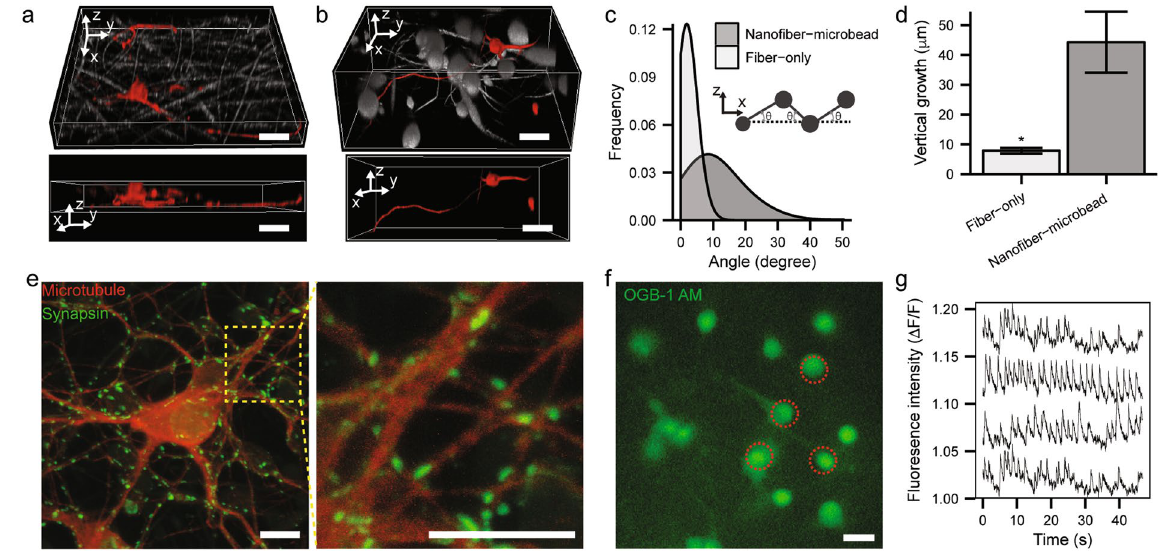
Figure 5. 3D reconstructed confocal microscopy images of neuronal culture (5 DIV) in ( a ) electrospun fiber- only and ( b ) nanofiber-micro bead mesh (scale bar: 10 μ m). ( c ) Normalized statistical distributions of off- horizontal angle of fiber orientation in fiber-only (white) and nanofiber-microbead scaffolds (gray) (see also the inset scheme). ( d ) Averaged overall vertical growth of neurites on fiber-only (white) and nanofiber-microbead scaffolds (gray) ( * p < 0.05). ( e ) Fluorescent images of immunostained neurons (14 DIV) on nanofiber- microbead mesh scaffold. Red and green colors represent microtubule and synapsin, respectively (scale bar: 10 μ m). ( f ) A fluorescence image of neurons (14 DIV) cultured on the nanofiber-microbead scaffold after staining Oregon Green 488 BAPTA-1 AM (scale bar: 10 μ m). ( g ) Representative traces of quantified calcium signaling ( Δ F/F) from cells indicated by red circles in ( f